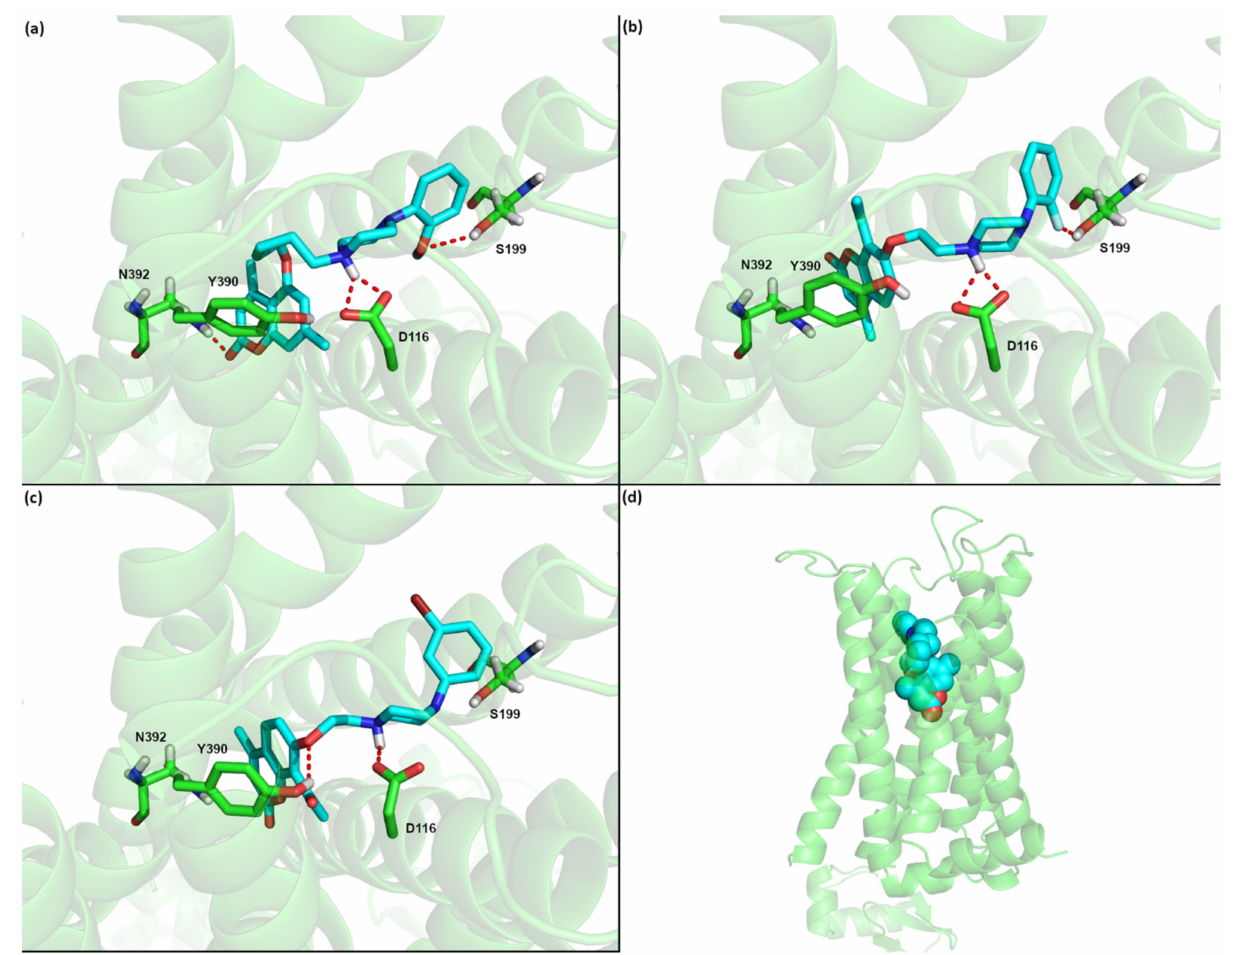
Figure 2. Predicted binding poses for the 5HT 1A receptor and compounds ( a ) 1a , ( b ) 6b, and ( c ) 6g , and ( d ) the location of the binding site in the GPCR. Nonpolar hydrogen atoms were omitted for